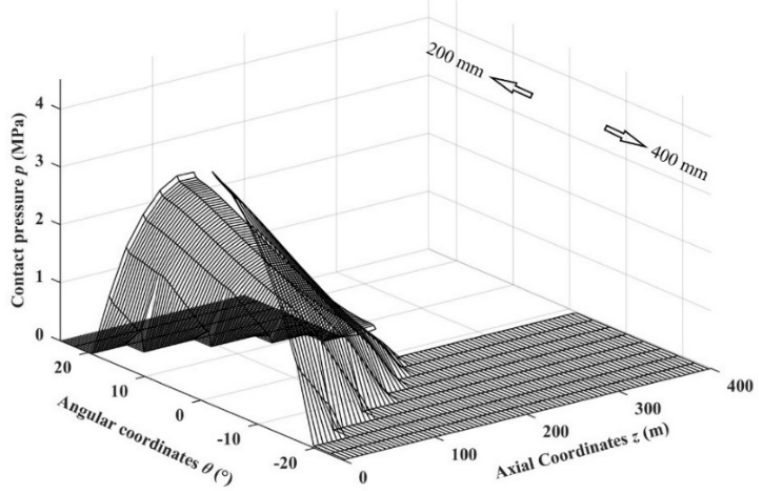
Figure 14. Contact pressure comparison with different bearing lengths.